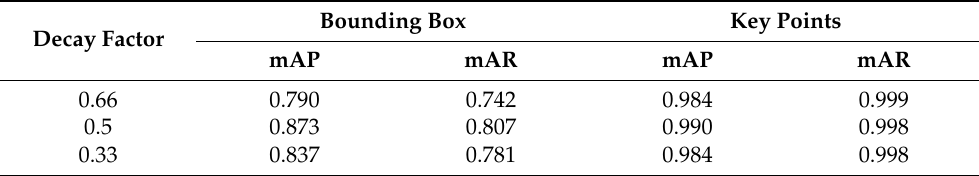
Table 5. Model performance with different learning rate decay factor. Decay Factor